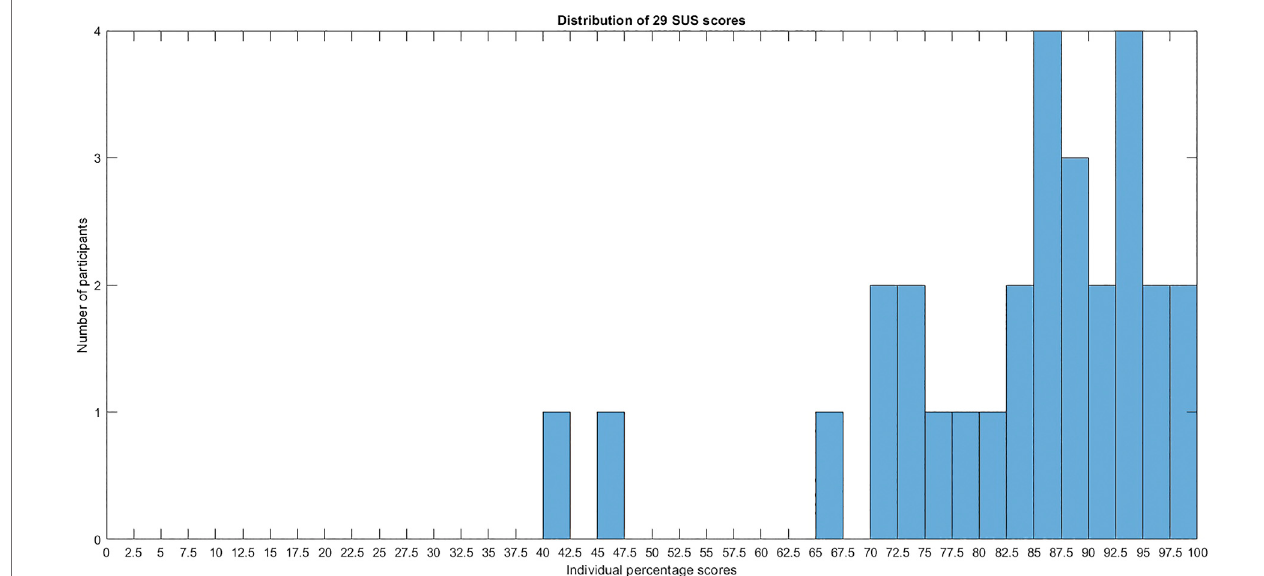
FIGURE 5 | The SUS scores achieved in the usability